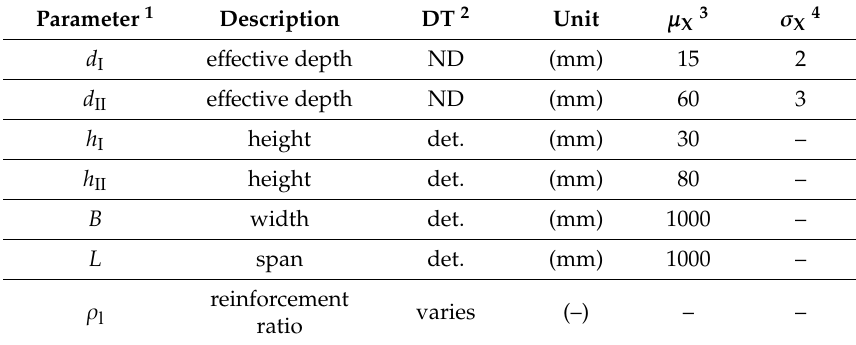
Table 1. Overview of the geometric dimensions—statistical description of the basic variables [9]. Parameter 1